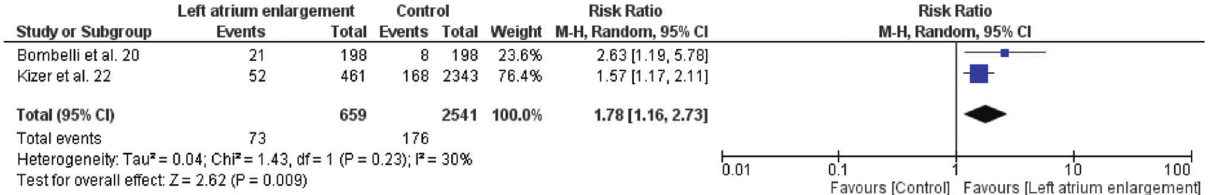
Figure 3.2 - The Risk Ratio and 95% confidence interval (CI) in the cardiovascular events (fatal and non-fatal), for Left Atrial enlargement group versus the Control group.